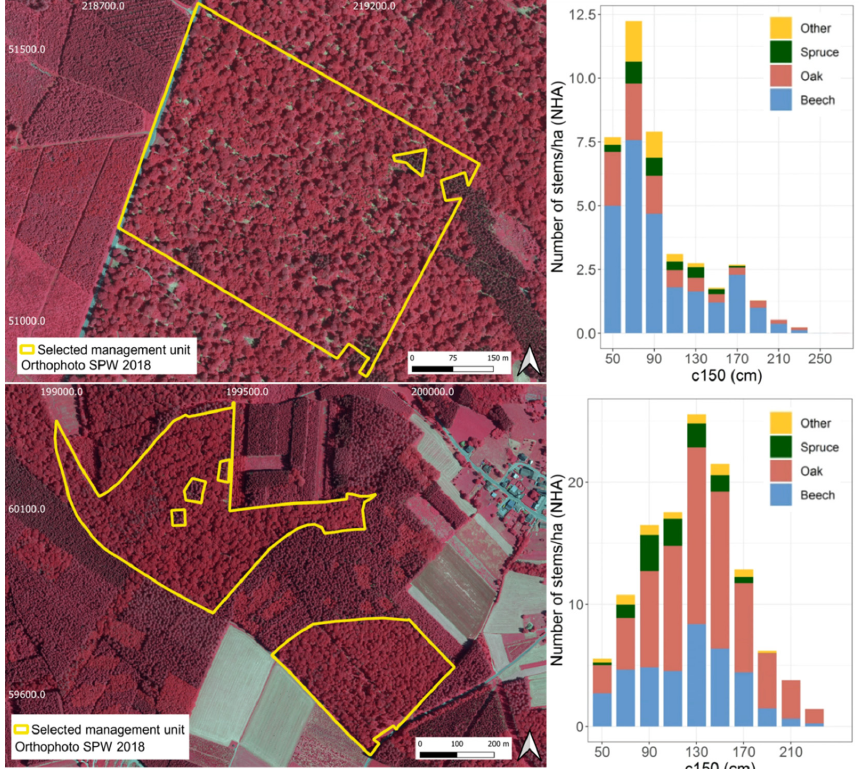
Figure 11. Illustration of the proposed method for two forest management units. SPW, Public Ser- vice of